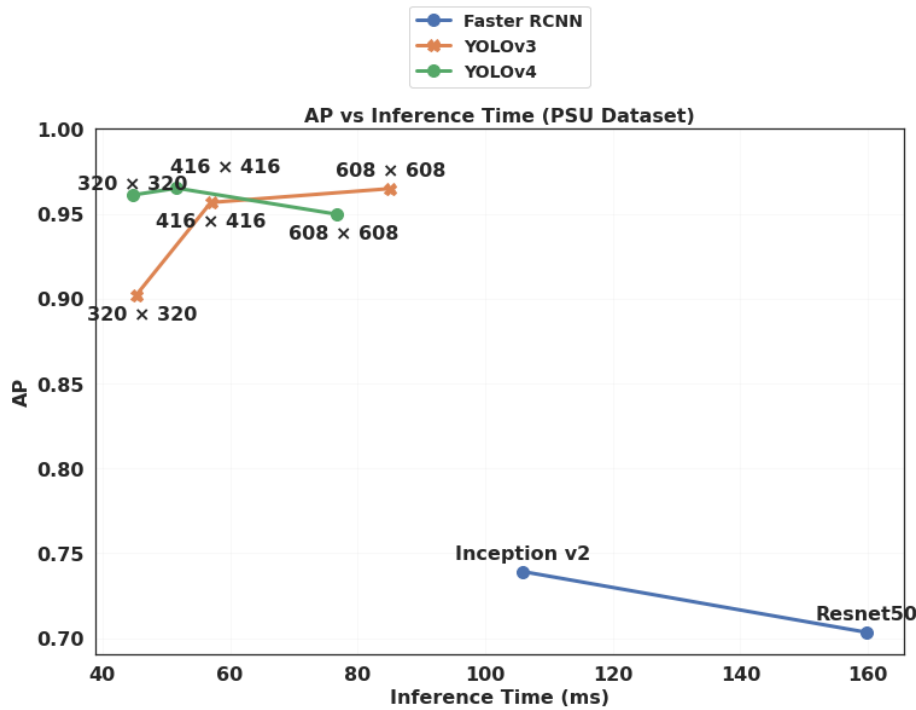
Figure 19. Comparison of the trade-off between AP (Average Precision) and inference time for YOLOv4 and YOLOv3 (with 3 different input sizes each) and for Faster R-CNN (with two different feature extractors), on the PSU (Prince Sultan University) dataset.